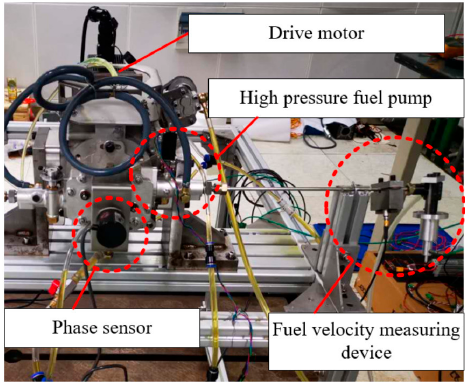
Figure 3. Modules of aircraft piston engine test system.